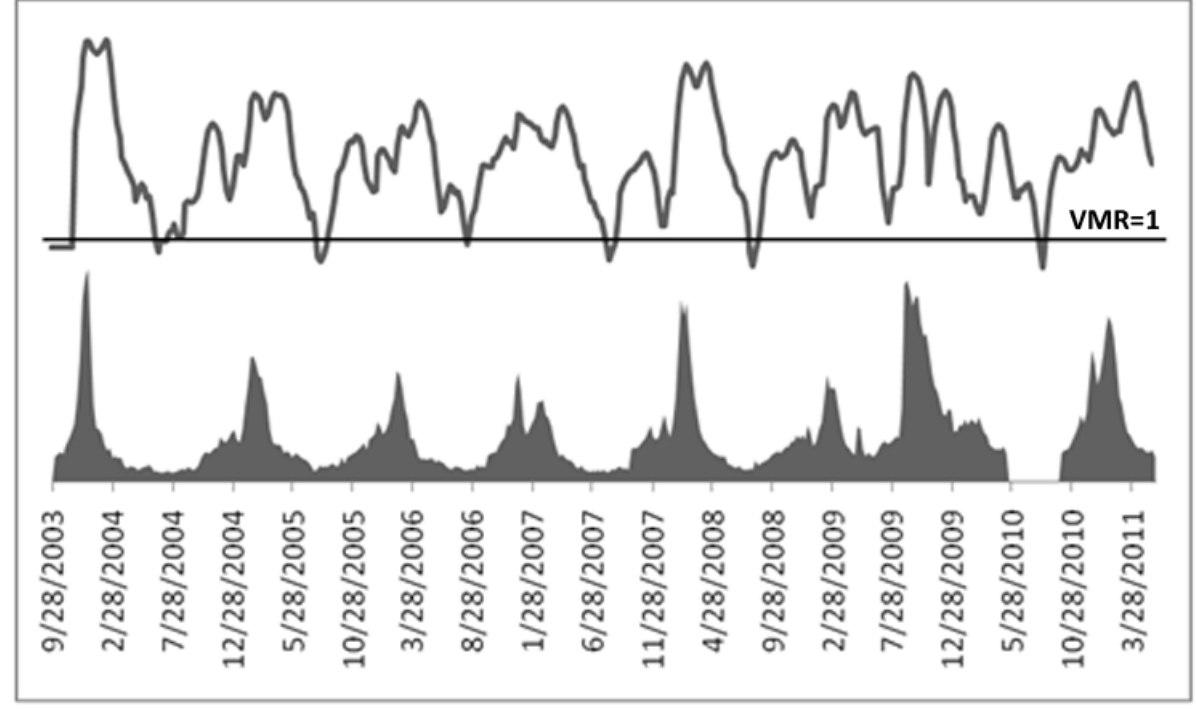
Figure 13. US Centers for Disease Control and Prevention data with the variance to mean ratio (VMR) line above, along the VMR = 1